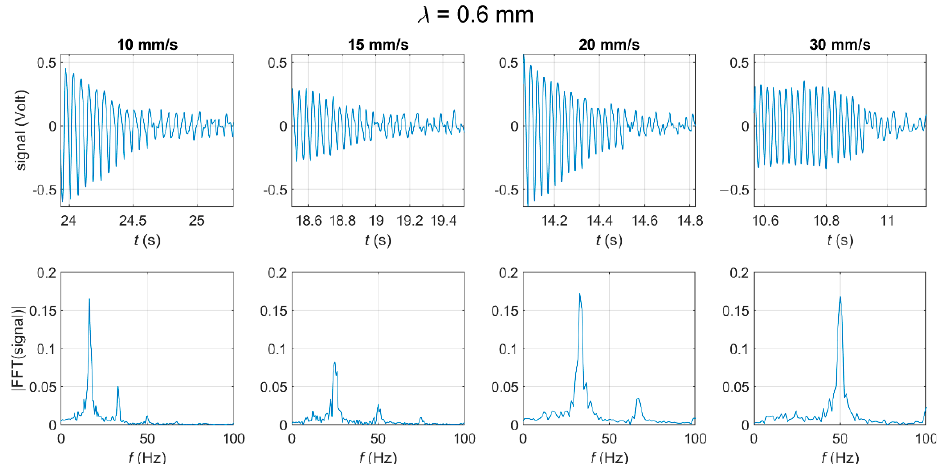
Figure 6. Temporal ( top ) and spectral ( bottom ) variation of the signal when the sensor is scanned over the pattern surface of 0.6 mm periodicity at different scanning speeds.